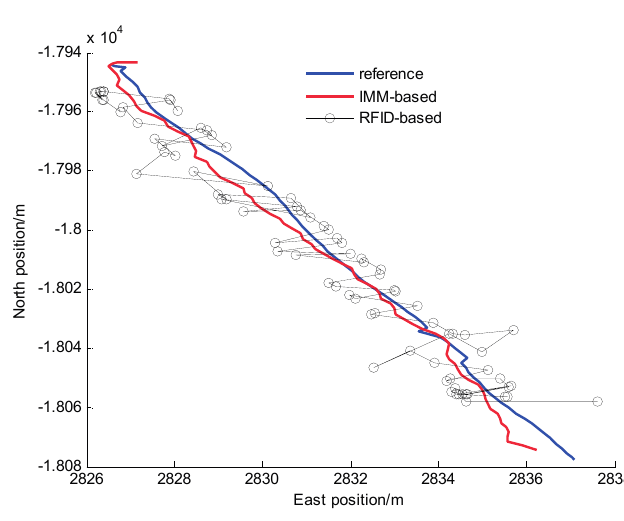
Figure 11. The east and north positioning